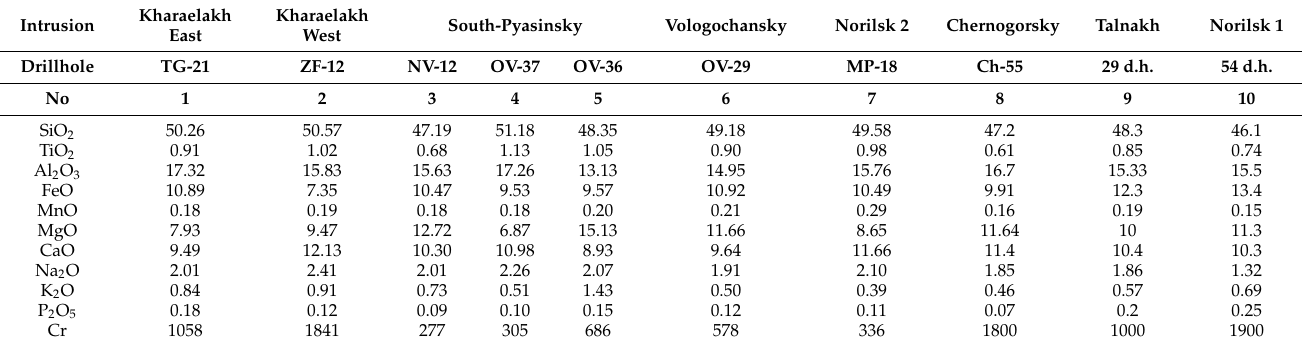
Table 2. Average mean compositions of the ore-bearing intrusions in the Norilsk